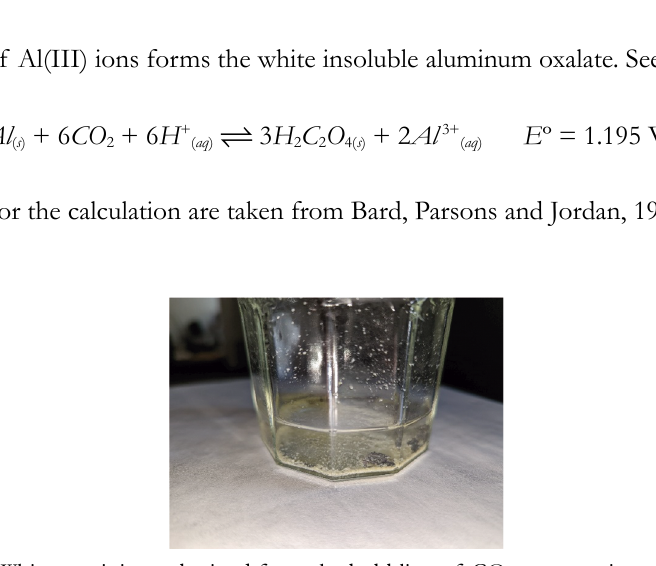
on an activated Al 2